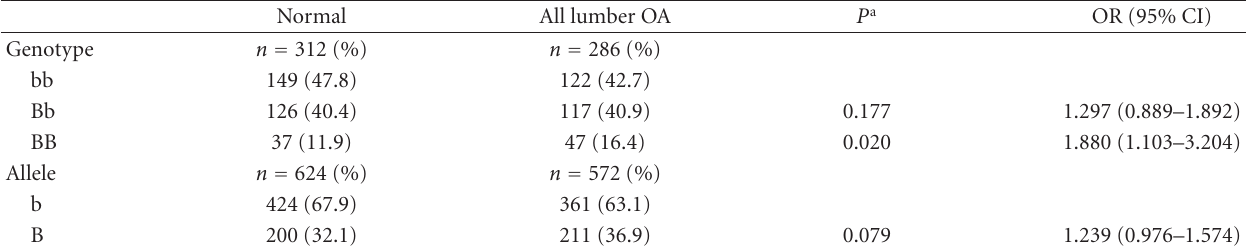
Table 4: Genotype and allele frequencies and odds ratios of MATN3 SNP6 (rs8176070) in control, lumbar OA cases. Normal All lumber OA